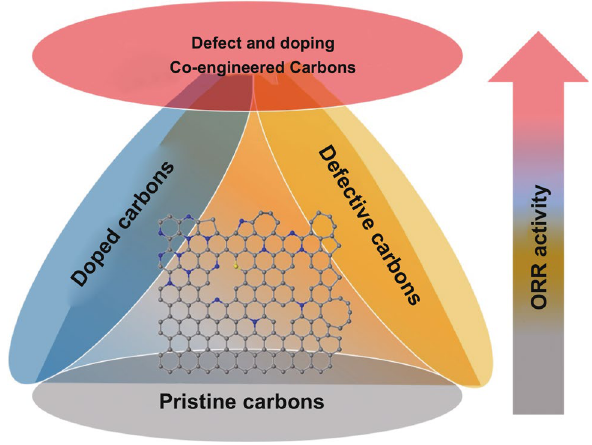
Fig. 11 Trend of ORR activity of various functionalized non-metal carbon